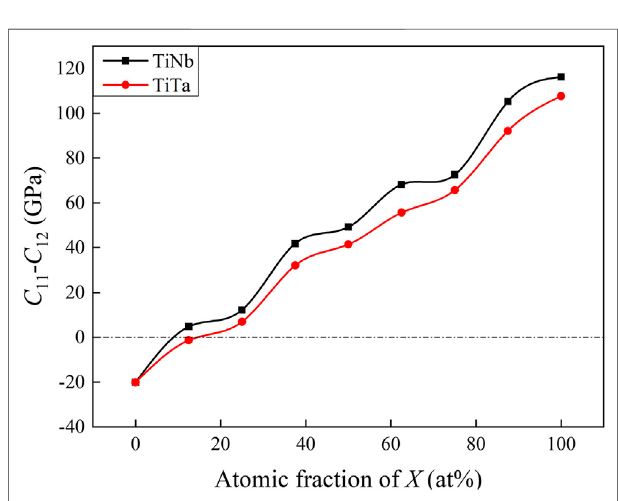
FIGURE 6 | Mechanical stability of β -Ti X ( X = Nb, Ta)